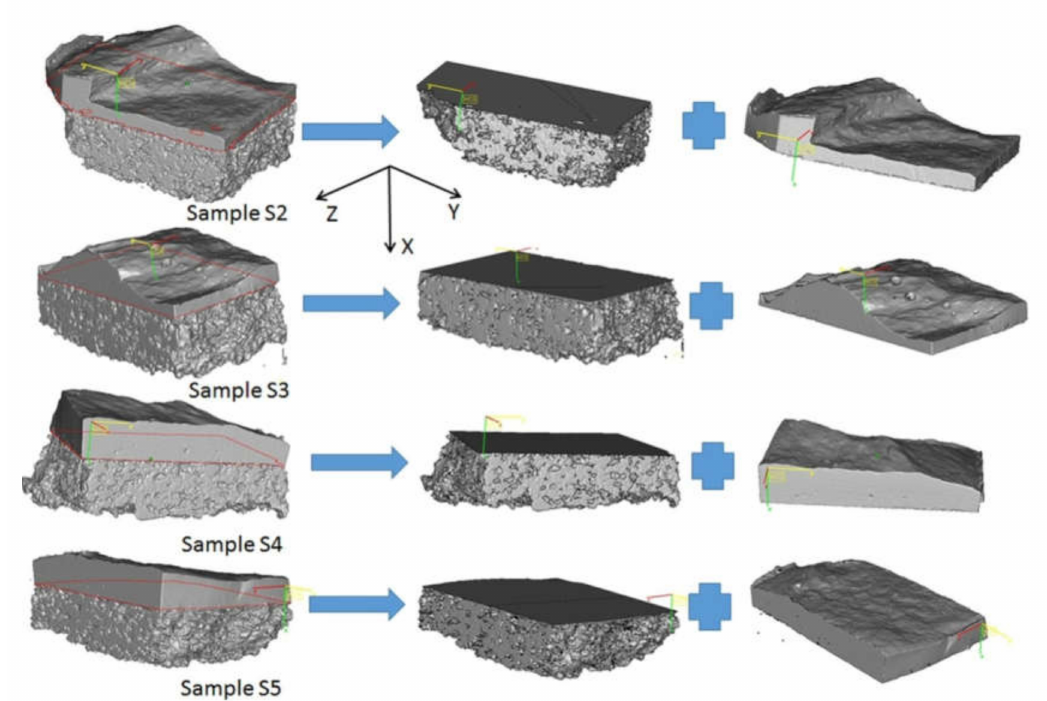
Figure 11. Visualization of the 3D stereolithography (STL) model for the multi-material composite (left column), composite 2 (middle column), and composite 1 (right